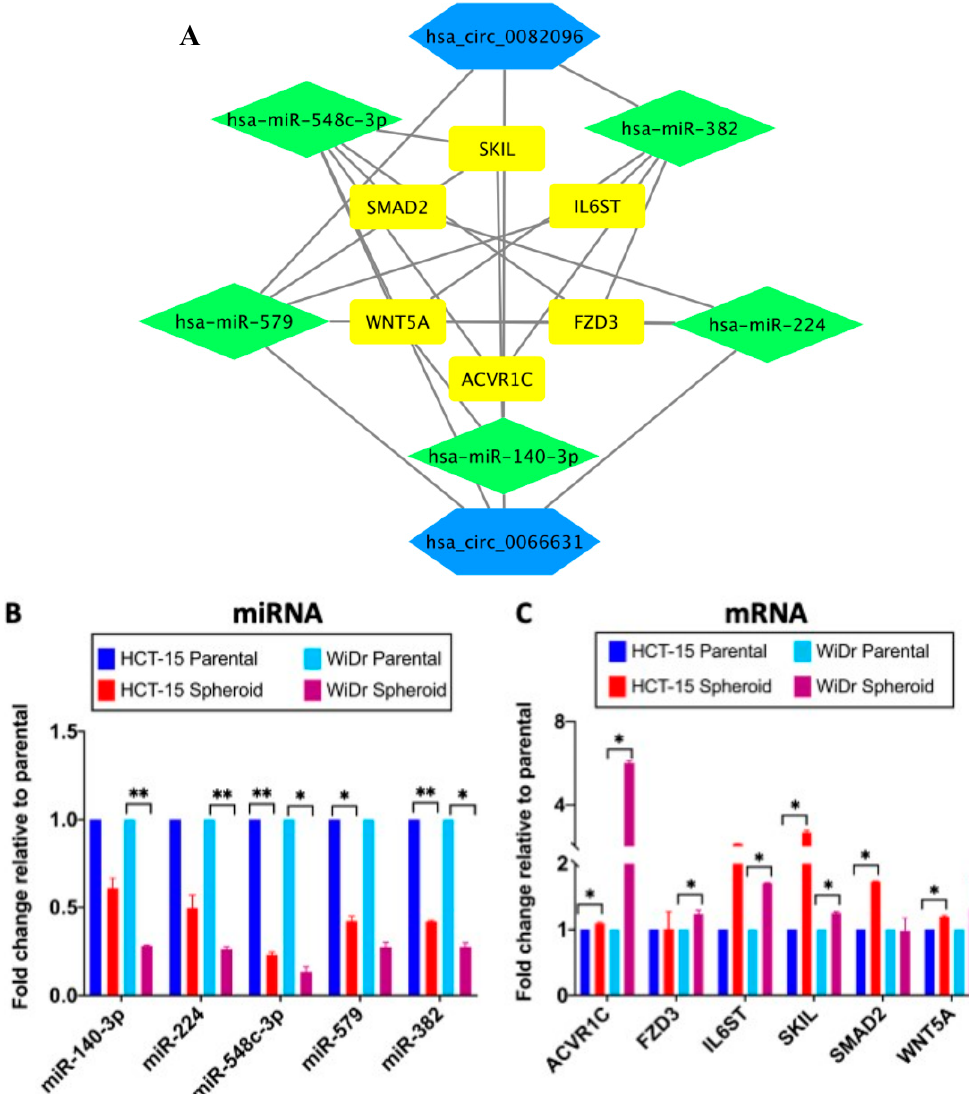
Figure 5. Circ_0082096 and circ_0066631 modulate stemness via a circRNA–miRNA–mRNA network. ( A ) CircRNAs (in hexagon), miRNA (in diamond) and mRNA (in box) that are predicted to regulate stemness. ( B ) Relative expression levels of the predicted miRNAs in the spheroid cells. Core miRNA analysis was performed by stem-loop qRT-PCR using small nucleolar RNA U6 as the normalization control. ( C ) Relative expression levels of predicted mRNA in the spheroid cells. Core mRNA analysis was by qRT-PCR using GAPDH as the control. * p < 0.05 and ** p < 0.01 were relative to the parental CRC cells ( B , C ). Table 2. CircRNA–miRNA–mRNA regulatory axis identified.